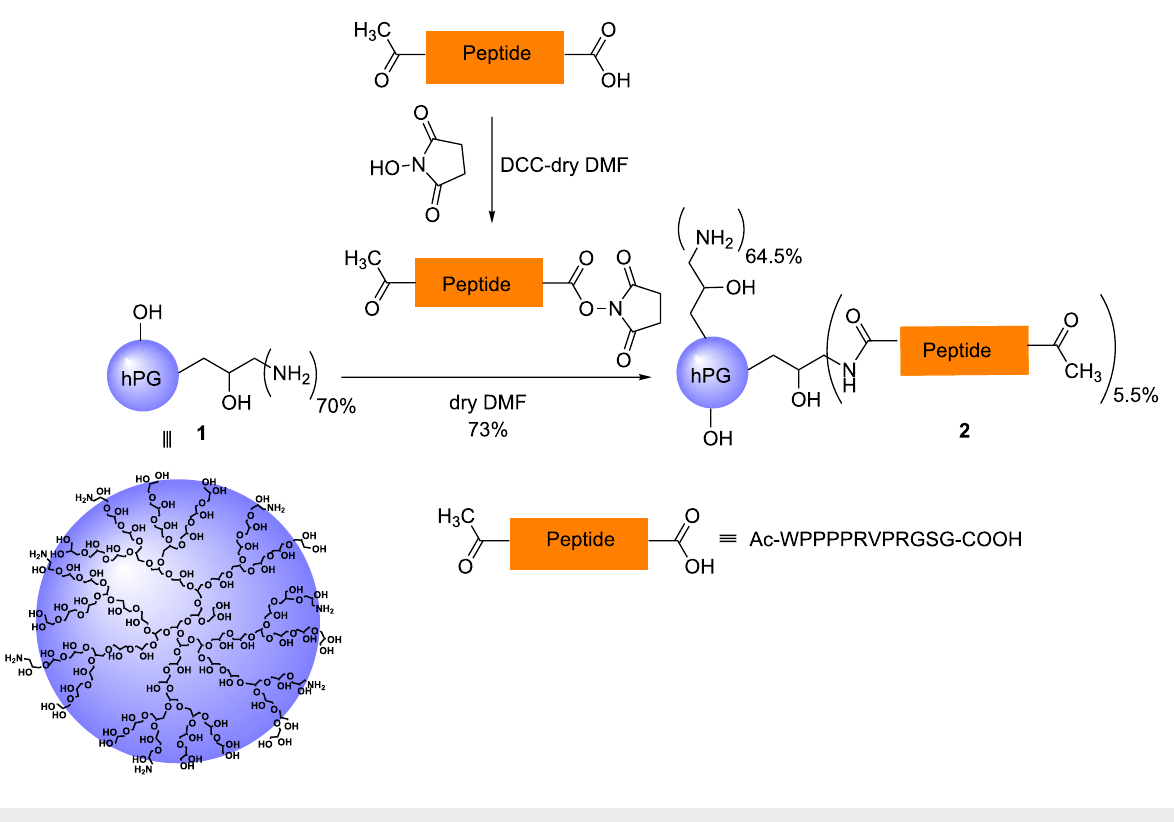
Scheme 1: Schematic representation of the synthesis of hPG-peptide conjugate 2 .